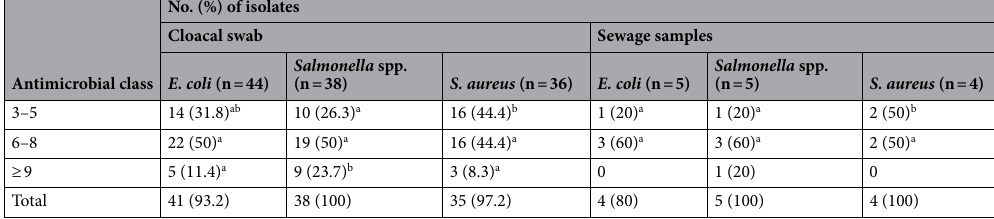
Table 1. Multidrug resistance patterns observed among E. coli , Salmonella spp., and S. aureus isolated from cloacal swab and sewage samples. a,b Values with different letters in the same row of antimicrobial class for each sample type differ significantly (p ≤ 0.05).